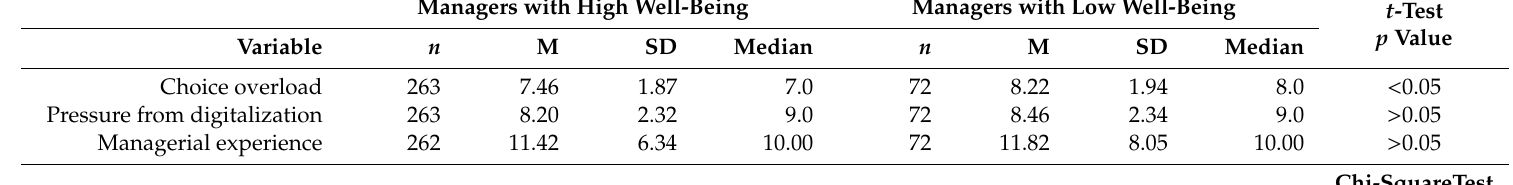
Table 2. Descriptive statistics of the independent variables for managers with high and low psychological well-being. Managers with High Well-Being Managers with Low Well-Being t